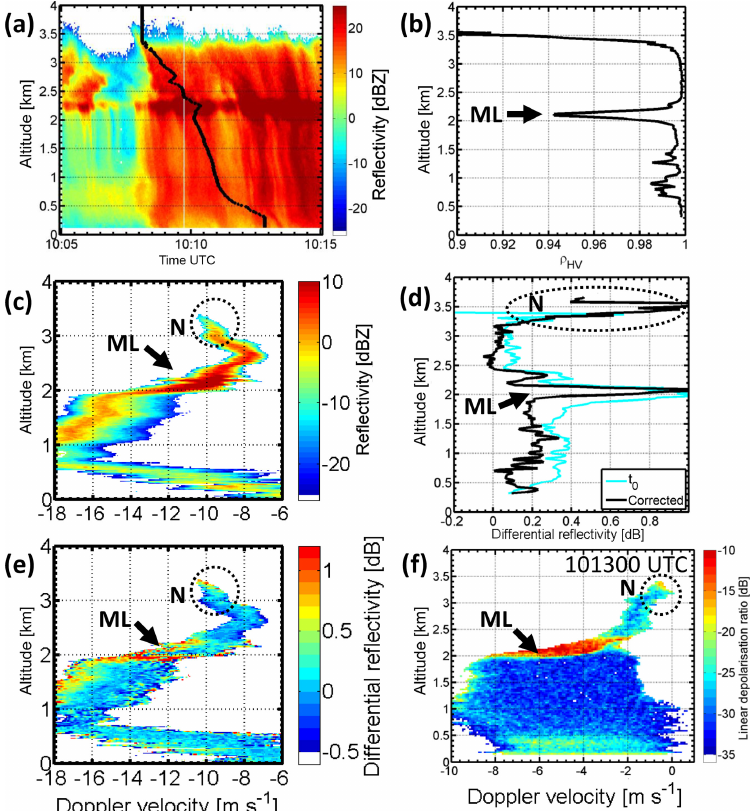
Figure 6. Panel (a) shows the retrieved fall streak at 10:12:50UTC obtained with TARA. Panels (c, e) are the fall streak corrected spectro- grams ( sZ and sZ DR , 45 ◦ elevation – note that the Doppler velocity contains the radial wind). Panels (b, d) show the fall streak corrected profiles of ρ HV and Z DR in black while light blue represents the vertical Z DR profile at 10:12:50UTC. Panel (f) shows the sL DR spectrogram of the vertical pointing Mira at 10:13:00UTC (all data displayed in the spectrograms have SNR > 10dB). ML points out the signature of the melting layer and N the signature related to the needle